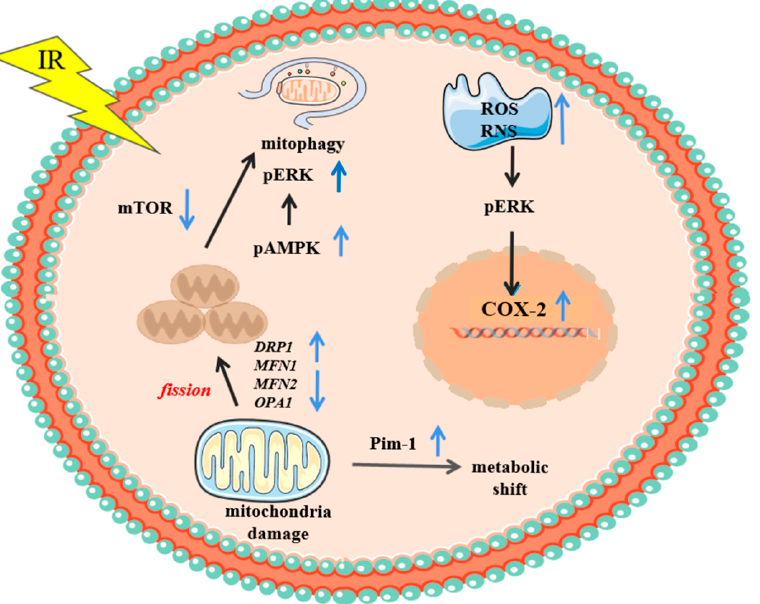
Figure 2. Regulatory factors involved in cytoplasmic-irradiation-related effects resulted from mi- crobeam irradiation. Please refer to main text for detailed information.